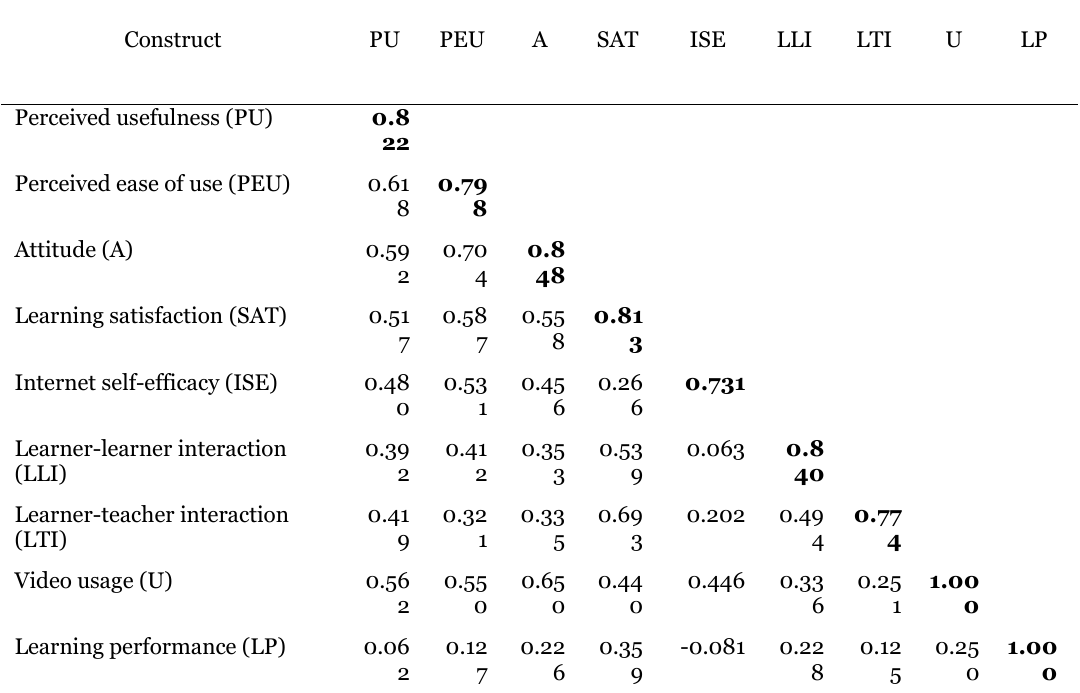
Construct Correlations and the Square Root of AVE